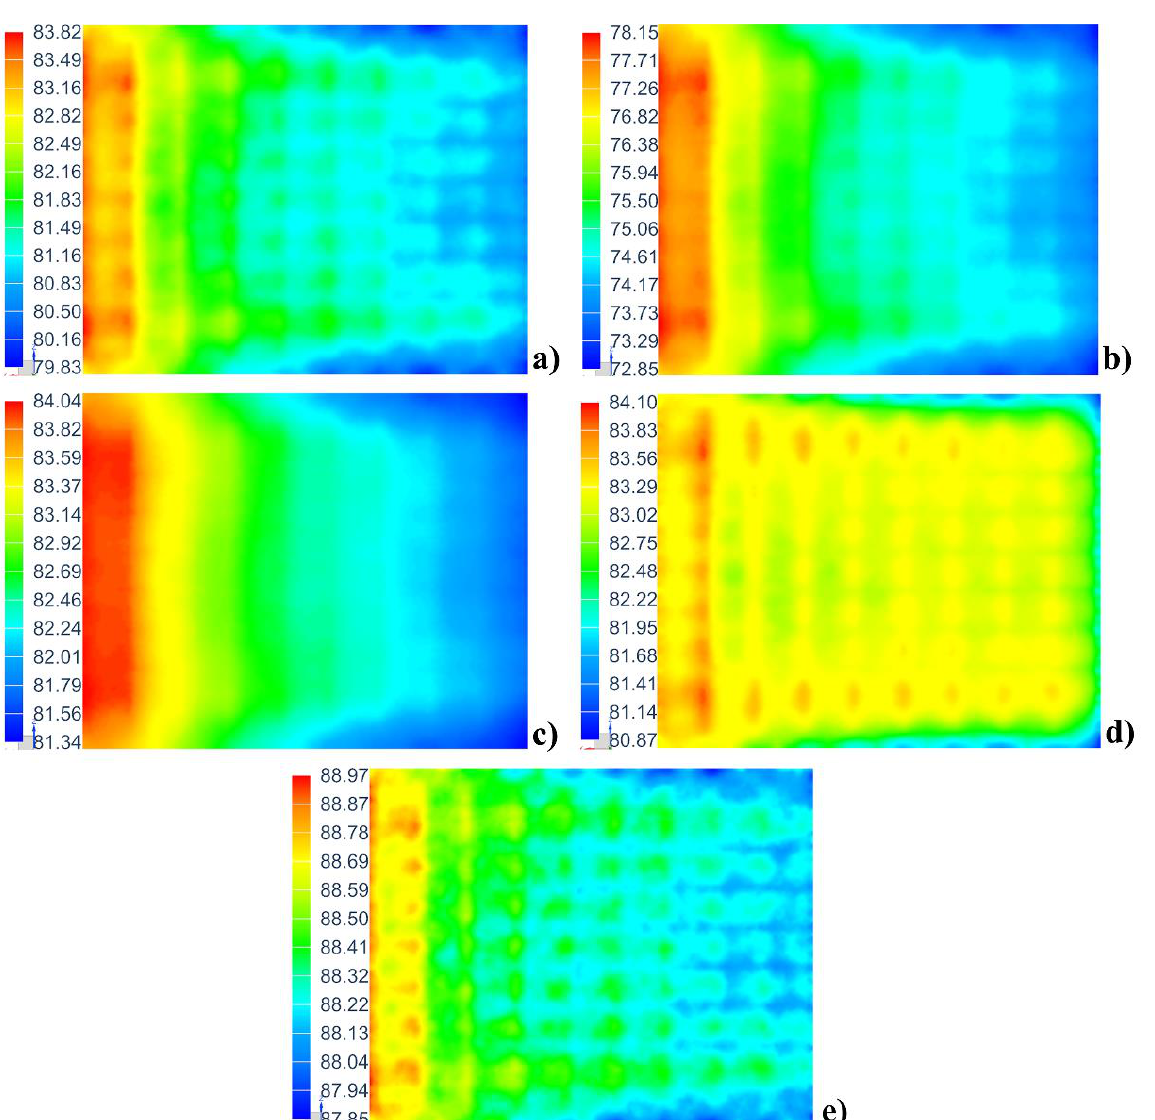
Figure 16. Maximum temperature difference on the mold plate.